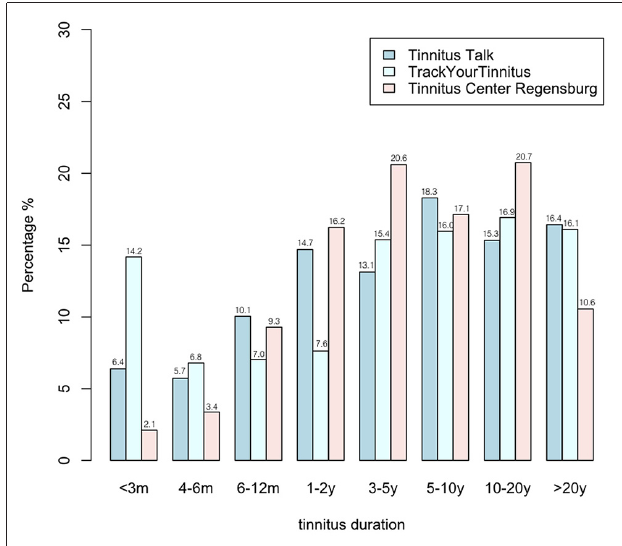
FIGURE 3 | Distribution of tinnitus duration in the three